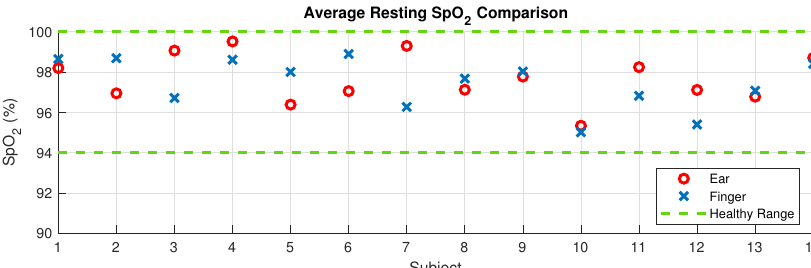
Figure 6. Mean resting SpO 2 levels taken for each individual subject for the right ear canal (red circles) and the right index finger (blue crosses). The mean was taken across the 60 seconds of SpO 2 data before the first breath hold sequence. The area within the two green dotted lines represents the healthy blood oxygen range of 94–100%.